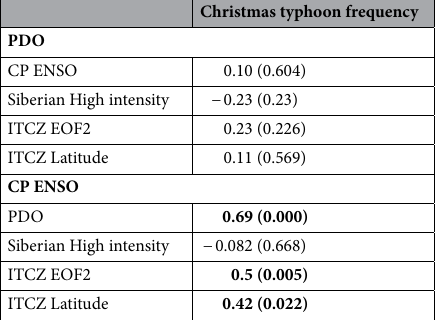
Table 1. Partial correlation coefficients of Christmas typhoons and selected climate indices when controlling for PDO and CP ENSO. Values in bold and inside parentheses indicate their corresponding significant partial correlation and p value using two-tailed distribution